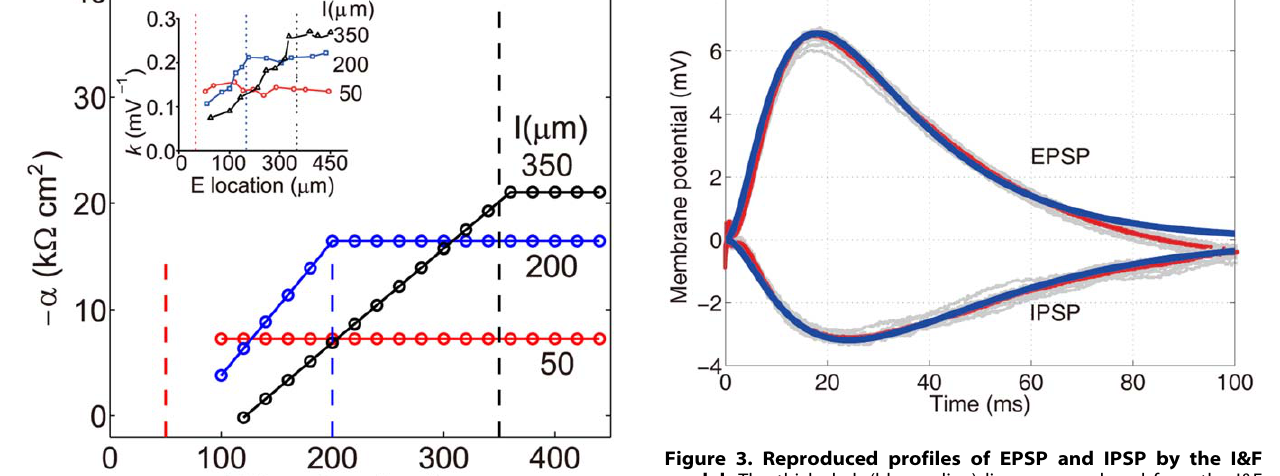
Figure 3. Reproduced profiles of EPSP and IPSP by the I&F model. The thick dark (blue online) lines are produced from the I&F model, the light gray lines represent EPSP and IPSP measured in the experiment for different trials, and the thin dark (red online) lines represent the trial-averaged responses in the experiment. Parameters in the I&F model are chosen as follows, f E ~ 1 : 16 | 10 { 5 S : cm { 2 , s Er ~ 5 ms, s Ed ~ 7 : 8 ms, f I ~ 3 : 71 | 10 { 5 S : cm { 2 , s Ir ~ 6 ms, and s Id ~ 18 ms. (See Methods for details).